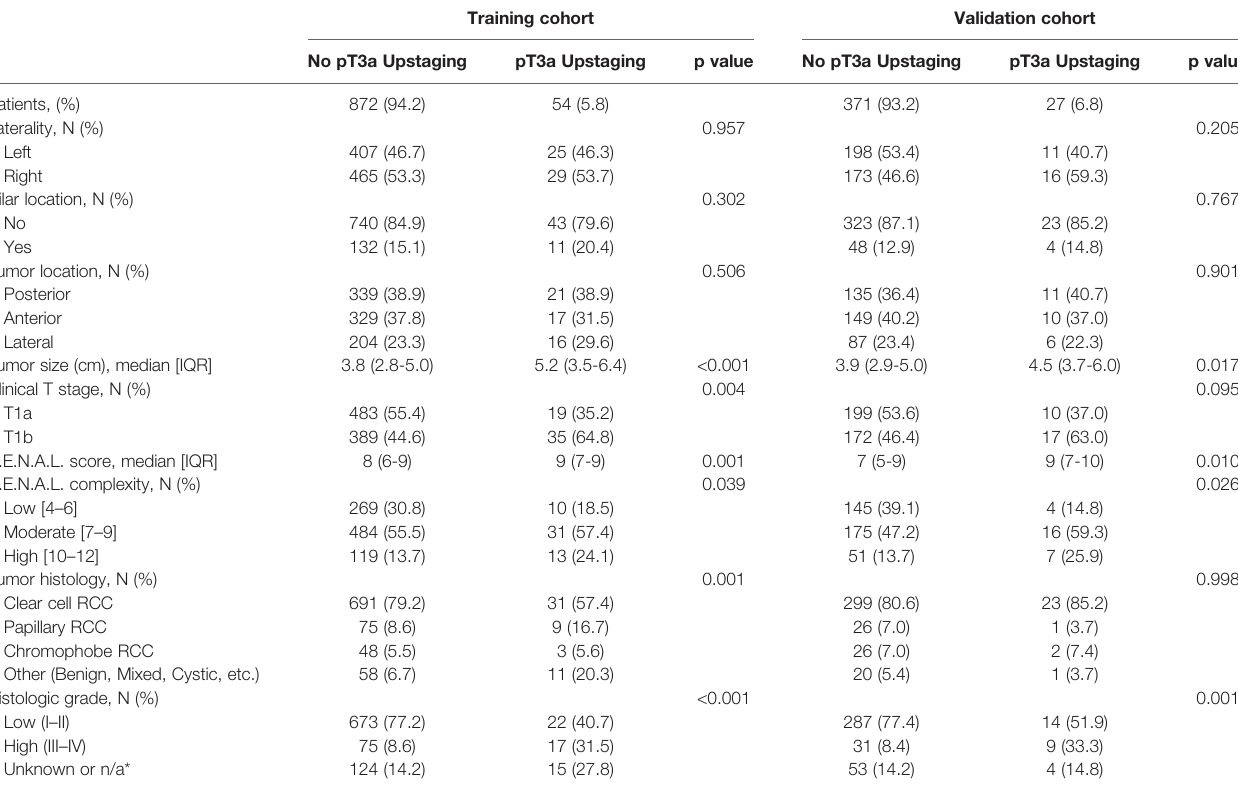
TABLE 4 | Tumor characteristics between those with and without pT3a renal cell carcinoma in training and validation cohort. Training cohort Validation cohort No pT3a Upstaging pT3a Upstaging p value No pT3a Upstaging pT3a Upstaging p value Patients, (%)